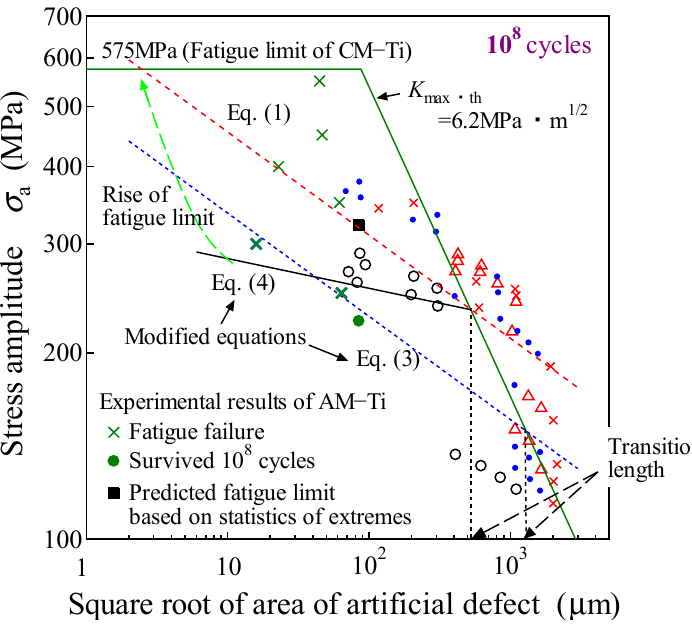
Figure 12. Kitagawa–Takahashi-Murakami diagram at 10 8 cycles.